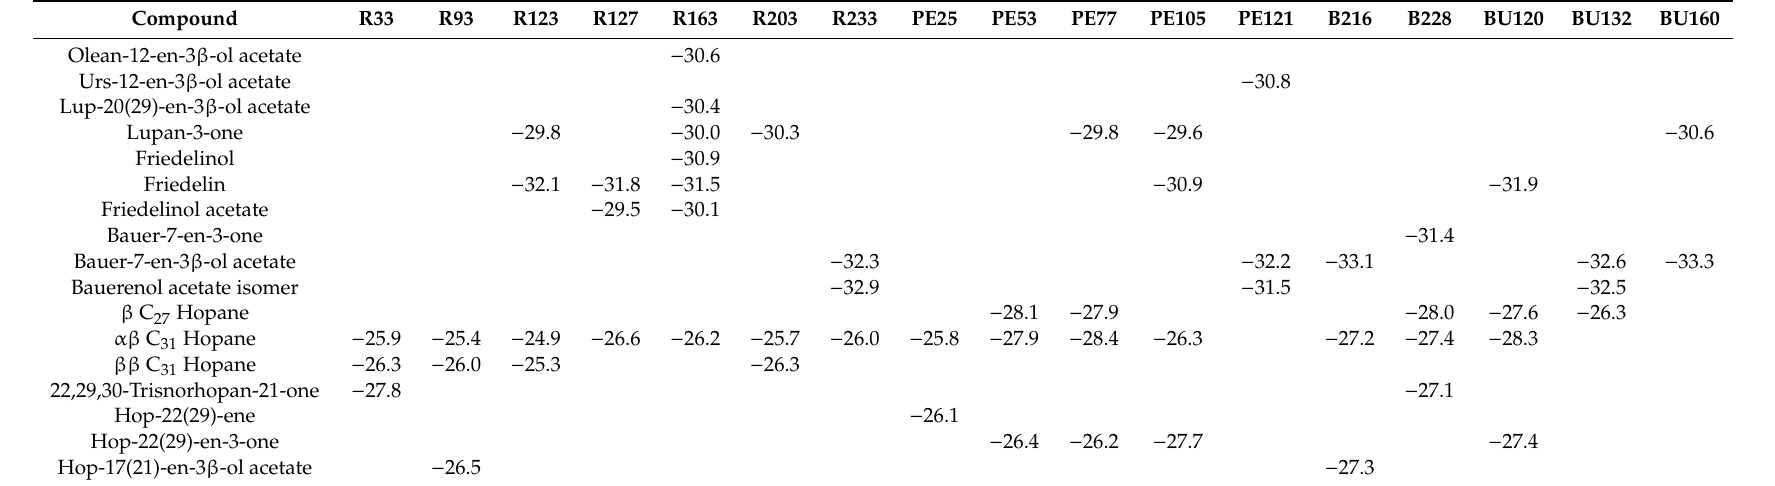
Table 5. δ 13 C values (% (cid:24) ) of some higher plant triterpenoids and hopanoid derivatives in the peat samples (R = Roñanzas; PE = Pendueles; B = La Borbolla; and BU =